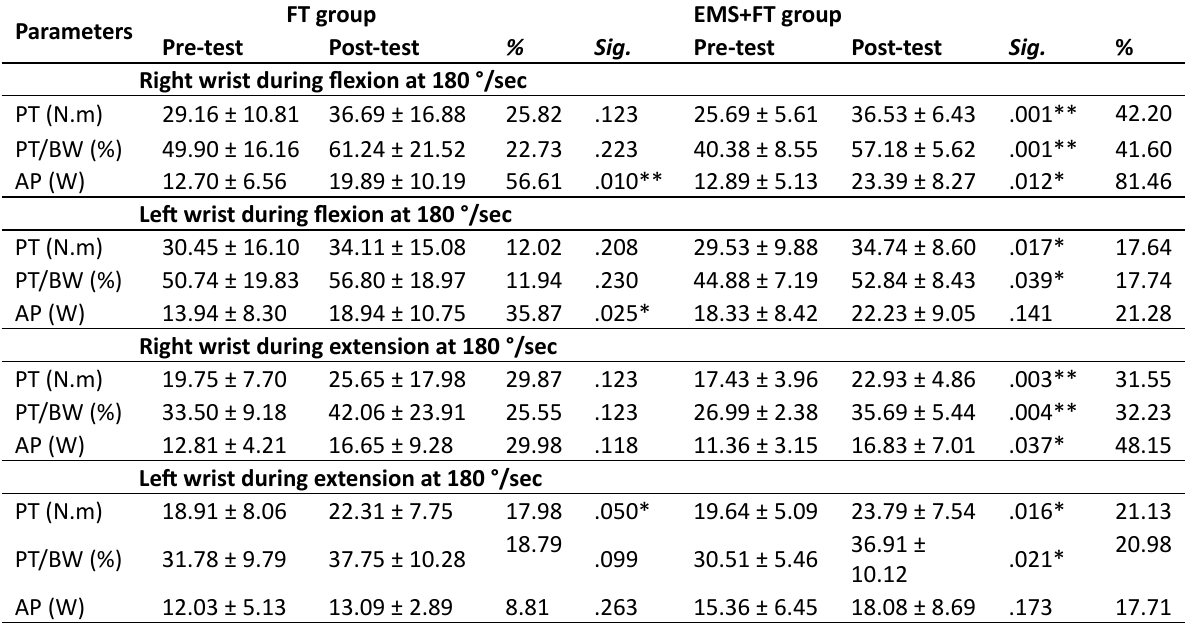
Table 3. Isokinetic endurance values and their mean differences obtained from pre and post-tests at 180 °/s for both right and left wrists during flexion and